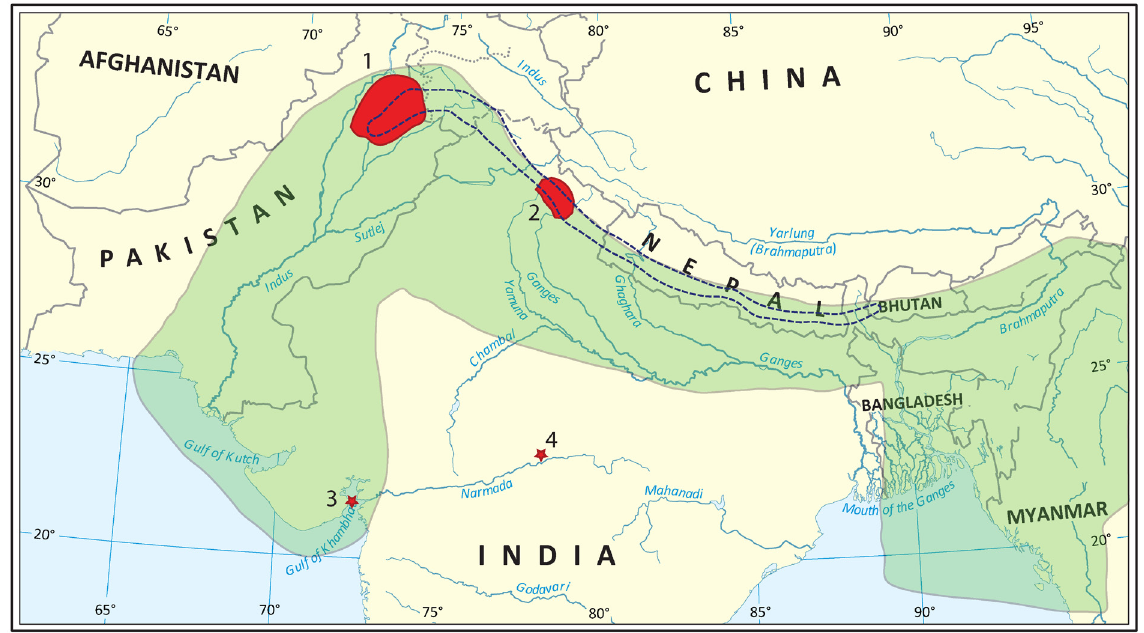
Fig. 1. Extent of the Himalayan foreland basin (green) on the Indian subcontinent, distribution of the Siwalik belt mountain range (dashed line), and the main localities that yielded geoemydid fossils. The main Siwalik-age localities here studied are marked with a red star. 1 . Potwar Plateau, Punjab, Pakistan. 2 . ‘Typical’ Siwalik Hills of India. 3 . Piram Island, Gulf of Cambay, India. 4 . Villages of Muwar and Doomar, Narmada Valley, India. Map modified from the United Nations, database of points from Flynn et al. (2013), range base from Valdiya